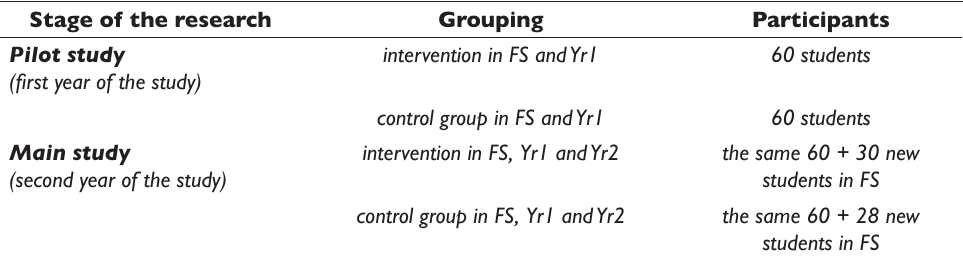
Table 1: Stages of the study, participating groups and numbers of students involved in the project Stage of the research Grouping Participants Pilot study intervention in FS and